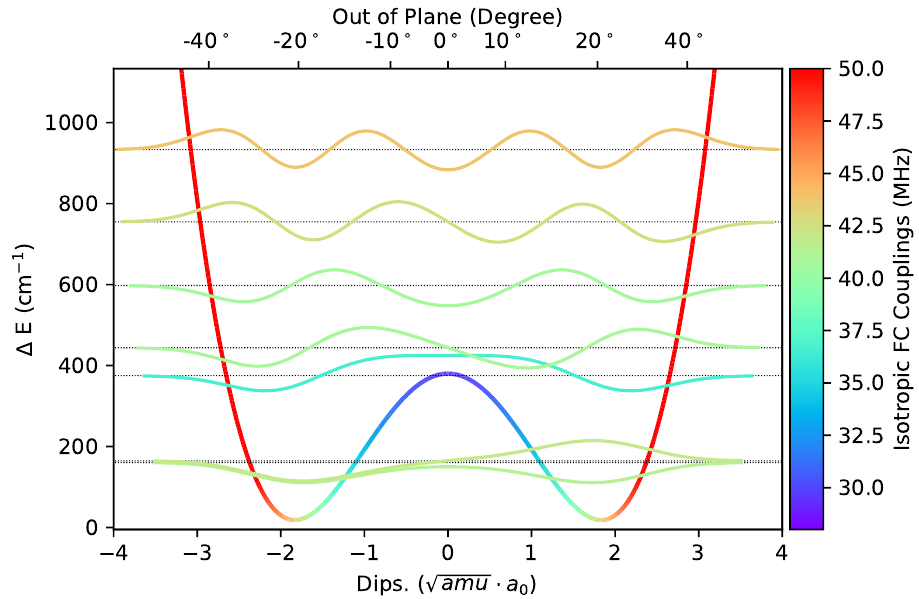
Figure 2. Graphical representation of the PES along the NO out-of-plane large amplitude motion computed at the B2 level. The TS energy was corrected by the values obtained at the CCSD(T)- F12/CC-PVDZ-F12 level of theory. The vibrational levels and wave functions with contribution above 0.5% at 300 K, computed using the variational DVR-based approach, are also reported. The color code reflects the value of a N in